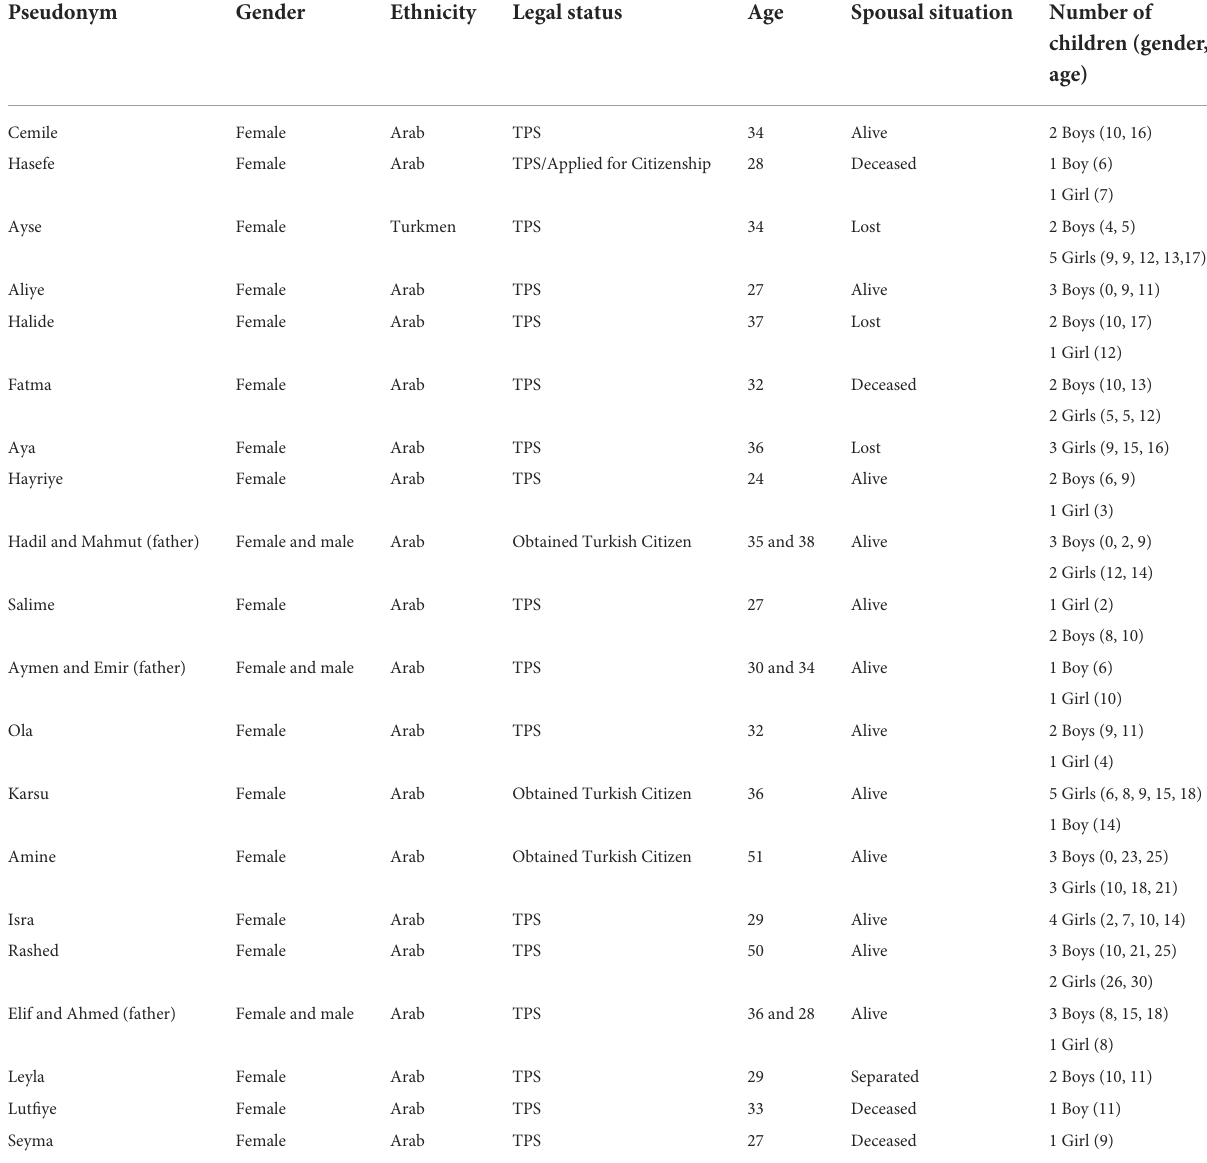
TABLE 1 Participant